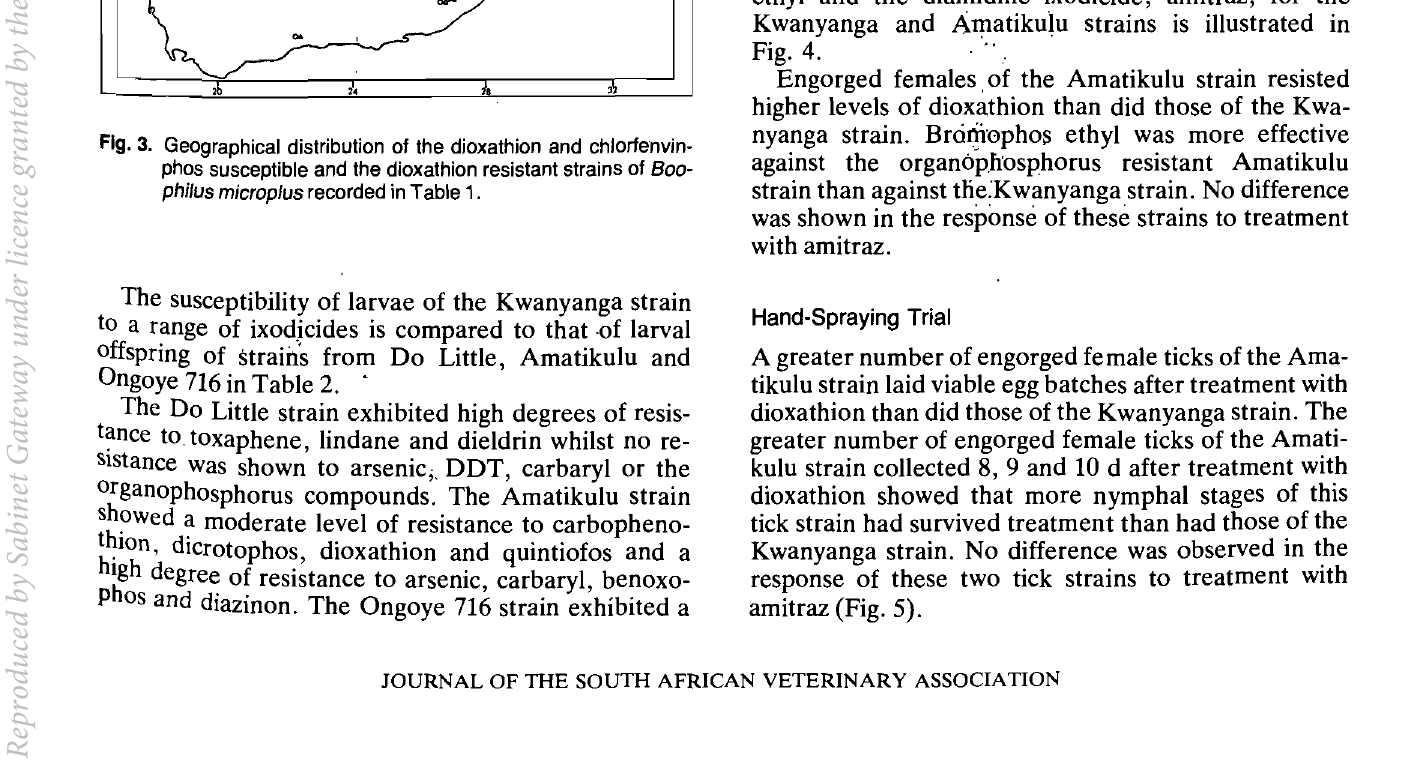
Fig. 3. Geographical distribution of the dioxathion and chlorfenvin phos susceptible and the dioxathion resistant strains of Boo philus microplus recorded in Table 1